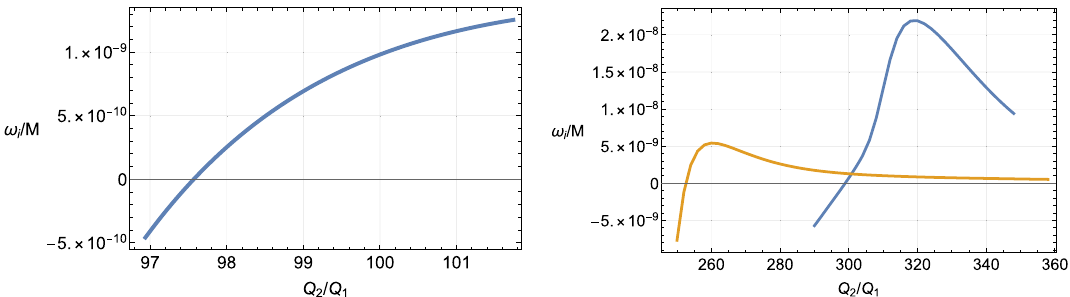
Fig. 5 We present three branches of unstable QNMs for sufficiently large Q 2 , with fixed ( m p , q 1 , q 2 ,(cid:11), Q 1 ) = ( 0 . 045 , 0 . 025 , 0 . 025 , 1 , 1 ). In each branch, there is a critical Q 2 beyond which unstable QNMs